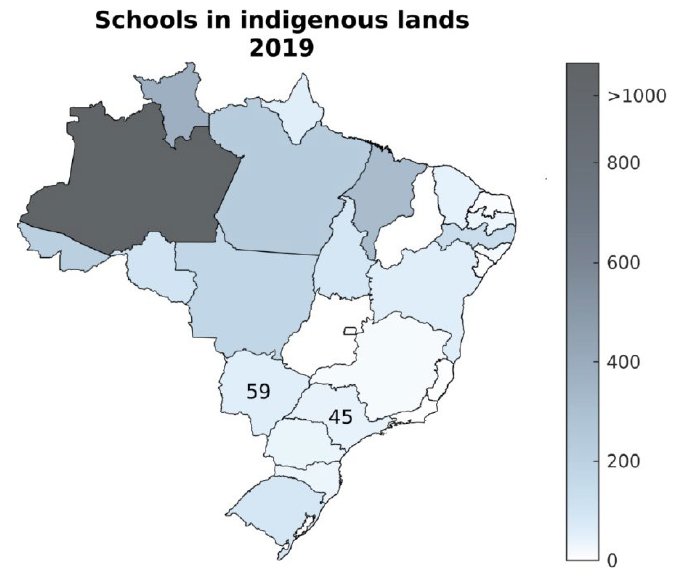
Figure 1. Distribution of indigenous schools in Brazil (data: INEP, School Census,